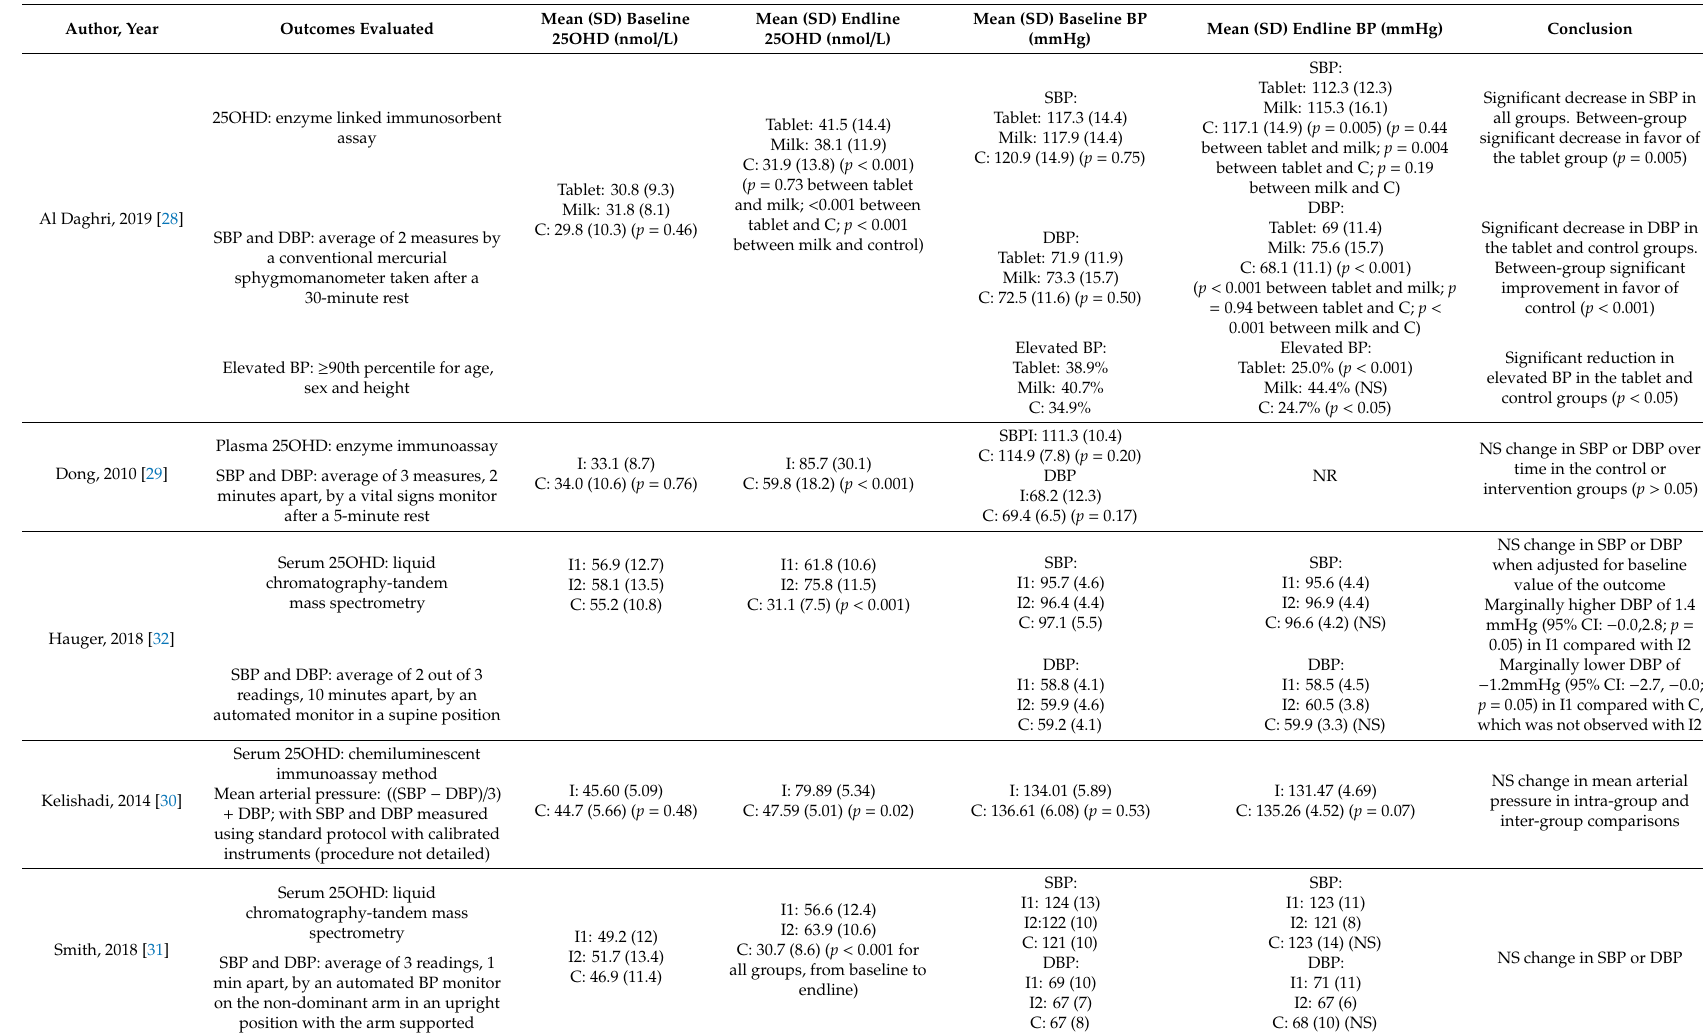
Table 4. Results of